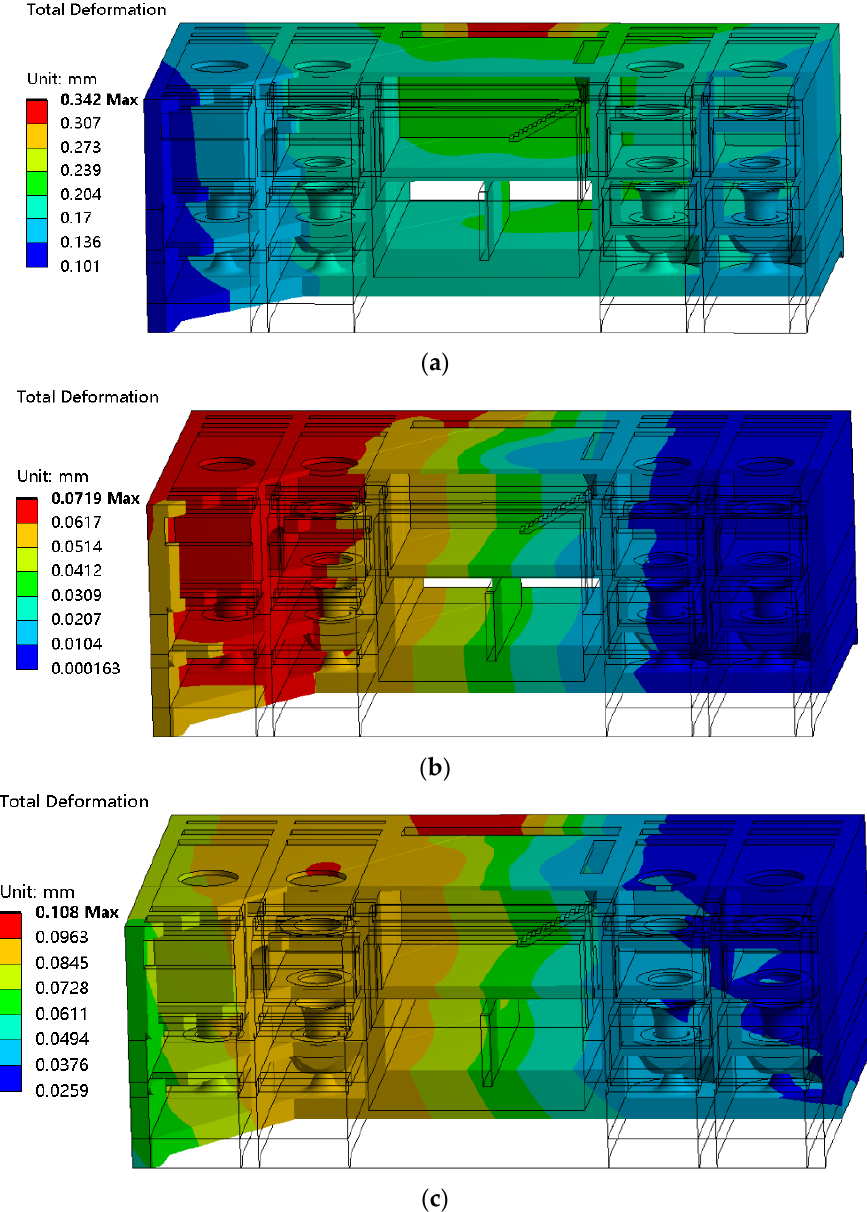
Figure 14. Total dynamic displacement of station building structure under three working conditions: ( a ) drainage condition; ( b ) diversion condition Ⅰ ; ( c ) diversion condition Ⅱ .